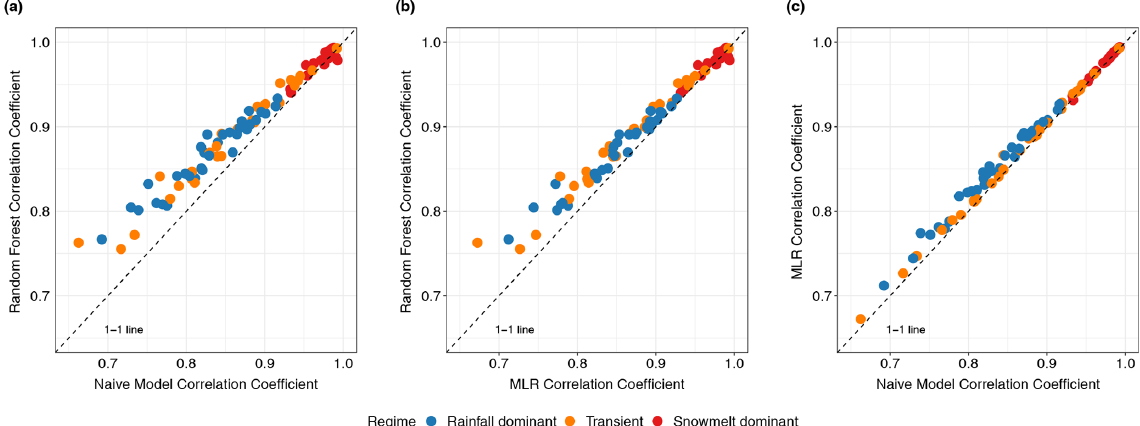
Figure 7. Pairwise scatter plots of the Pearson correlation coefficient between forecasted and observed values for (a) RF vs. the naïve model, (b) RF vs. MLR, and (c) MLR vs. the naïve model. Each dot represents a watershed ( n =